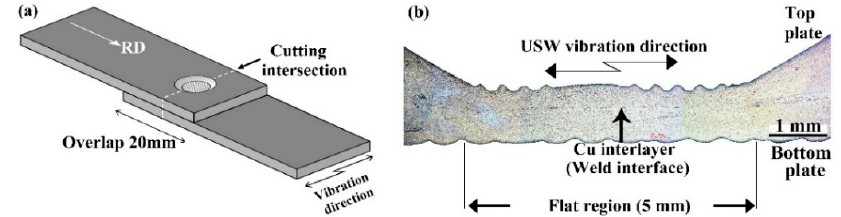
Figure 2. ( a ) Schematic of welded sample; ( b ) typical welded joint intersection (RD: Rolling direction). Lap shear tensile tests on the welded specimens were performed using 0.5 ton-f, DS-3100 (Showa inc., Tokyo, Japan) desk type tensile machine under 1mm/min. cross head speed. The tensile axis was along the length of plates (i.e., perpendicular to vibration direction). For hardness evaluations, an MVK-H1 microhardness testing machine (AKASHI inc., Yokohama, Japan) used according to ASTM E-384-2011. A hardness measurement for welded samples has been conducted inside the flat region. From the point of view of using or not using interlayer, two types of USW joints were produced, including: